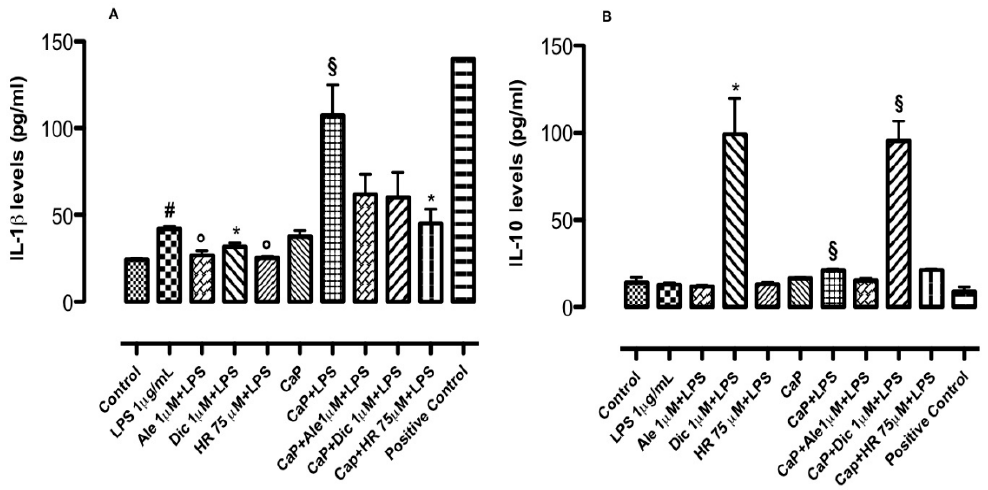
Figure 8. E ff ect of CaP with and without Ale, Dic, HR, on ( A ) interleukin (IL)-1 β and ( B ) IL-10 in co-culture systems (osteoblasts-macrophages) treated with lipopolysaccharide (LPS) (1 µ g / mL). Measurements were performed 3 days after LPS (1 μ g/mL) stimulation. The exposure of cells to materials with and w/o Ale, Dic, and HR started 24 h before the inflammatory insult. Results (expressed as picograms per mL of supernatant) are mean ± dev.st. of three independent experiments ( n = 6). ( A ) # p < 0.001 vs. control; ° p < 0.01 vs. LPS (1 μ g/mL); § p < 0.01 vs. CaP alone. #